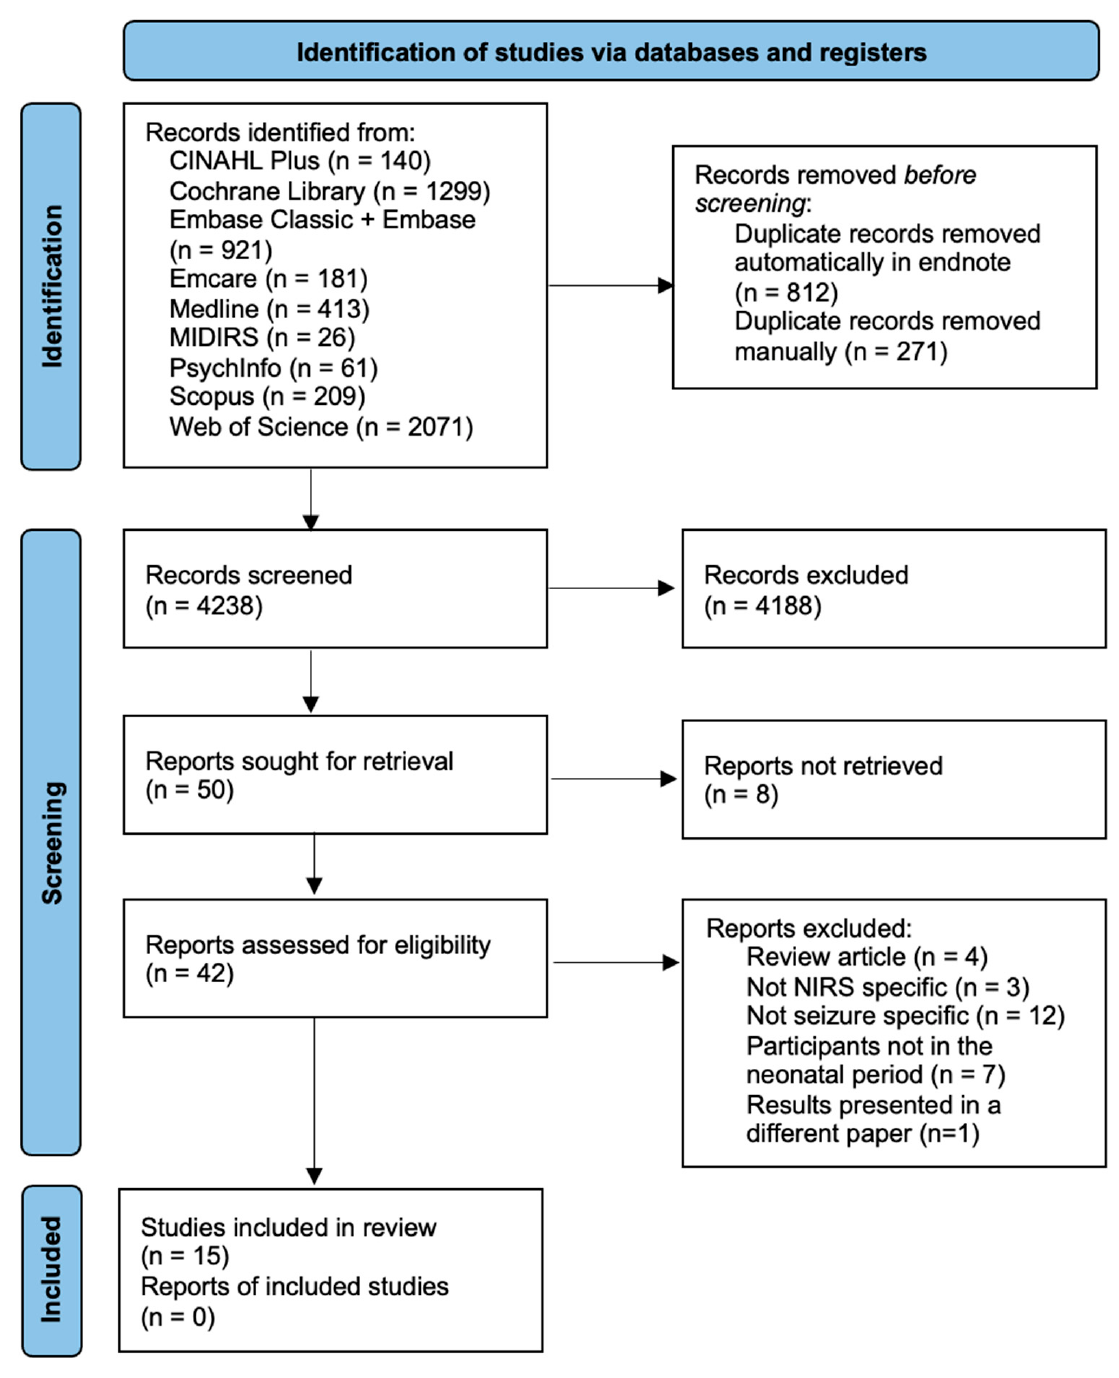
Figure 1. PRISMA flow chart showing identification of studies . Table 2. Preclinical data extracted from the included articles.